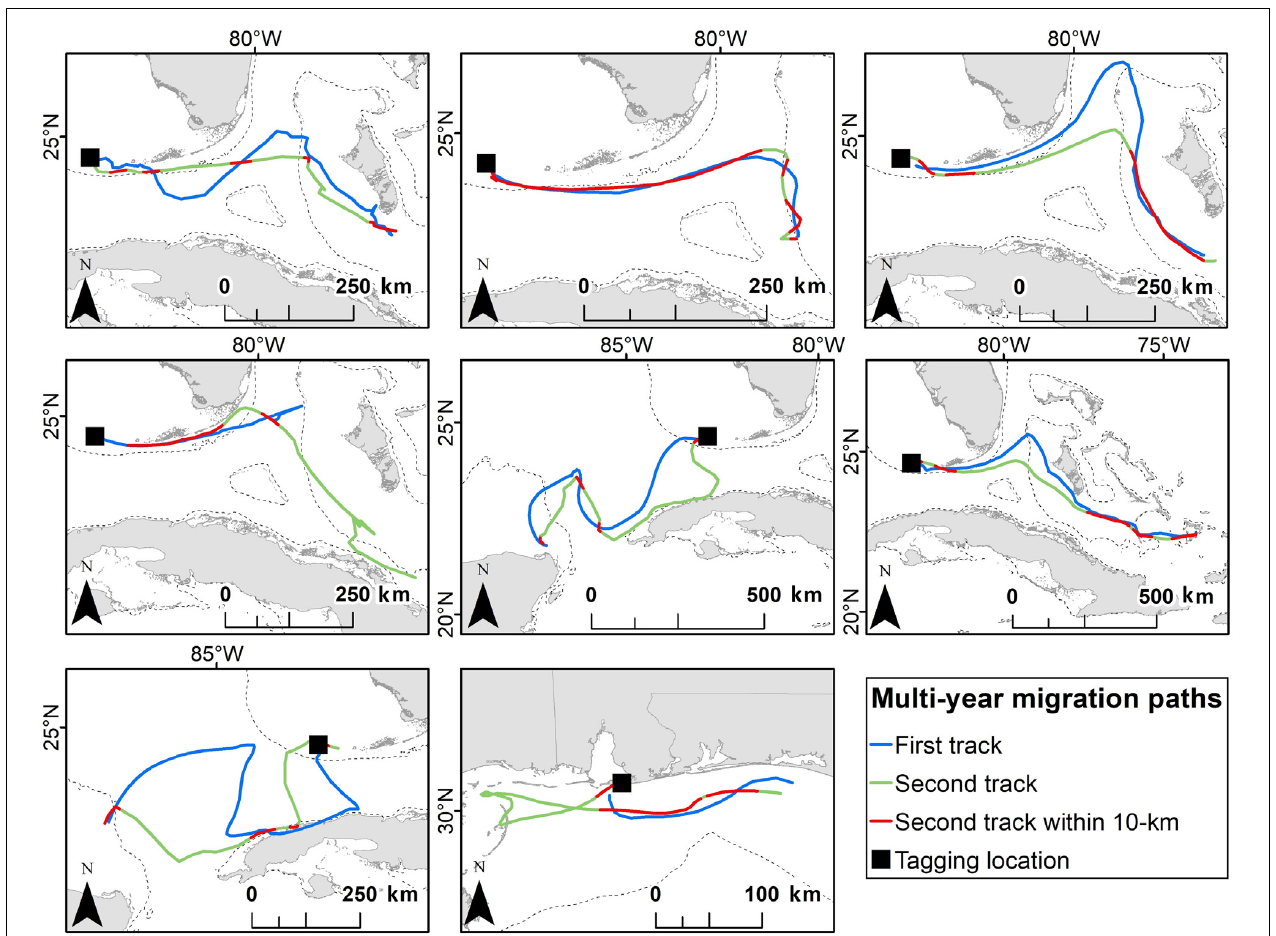
FIGURE 4 | The repeatability of migration paths taken by eight adult female loggerhead sea turtles ( Caretta caretta ) after being tagged at Dry Tortugas National Park, Florida (first seven panels) and Gulf Shores, Alabama (last panel). Parts of the track where the second post-nesting migration was within 10 km of the first post-nesting migration are indicated in red. The 200 m bathymetric contour is shown as a dashed